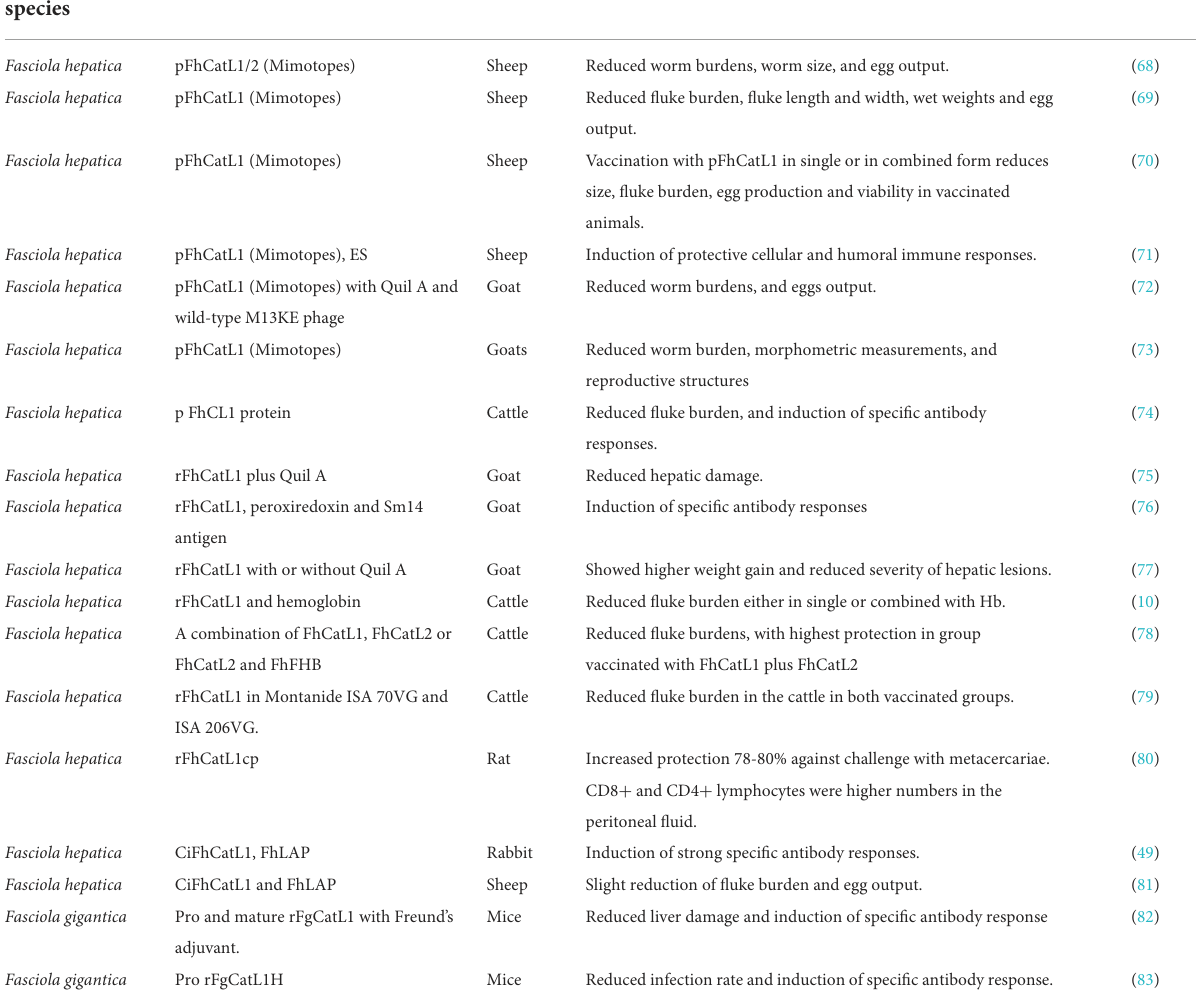
TABLE 3 Previous studies on Fasciola cathepsin L1 as a vaccine antigen in different animal